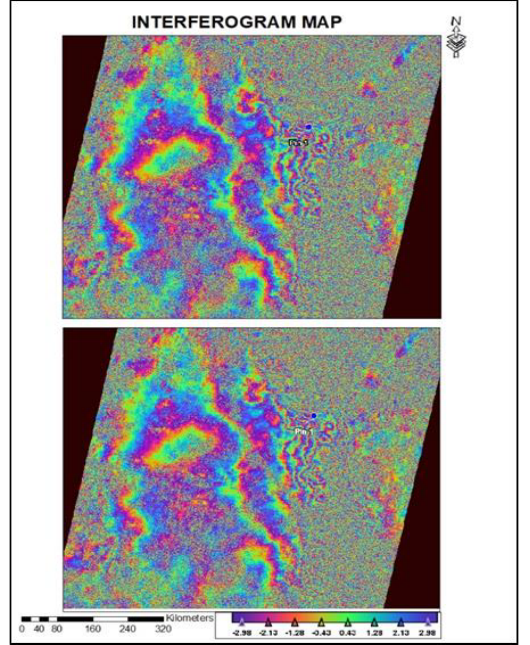
Figure 5 interferogram S-1 SAR interferometry. Fringes generated from two images of the NCR area of India, with a time interval of 12 days by VV polarization (upper) and VH polarization